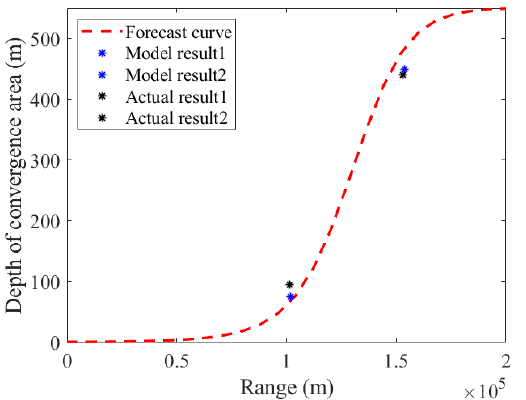
Figure 14. The forecasting curve of the depth of the convergence area (the red dotted line) and the calculating results of the model (blue dots) and actual ocean front (black dots) on 1 January (SD = 100 m). We found that the depth distribution of the convergence area in the model and the actual condition were in good agreement with the forecasted curve with only a little difference.